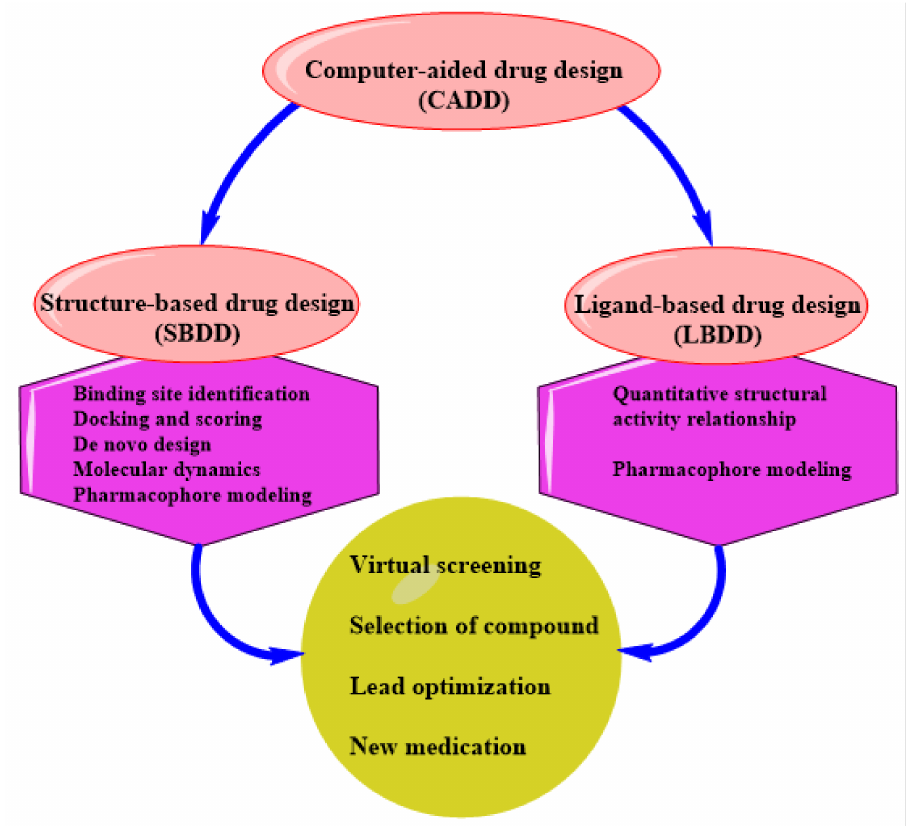
Figure 1. An illustration of